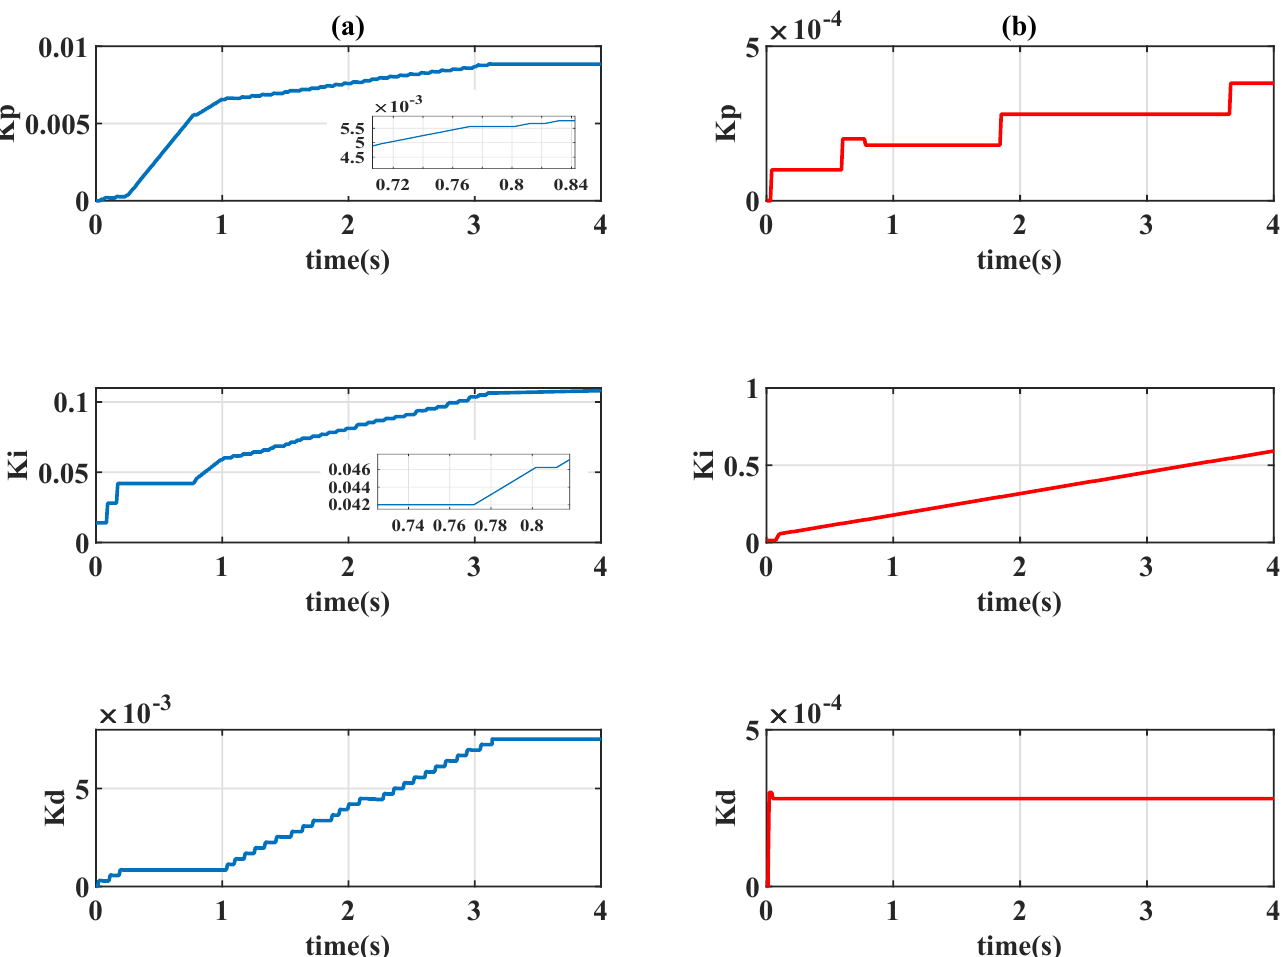
( z ) ; ( b ) Sarsa C 1 ( z ) Q S